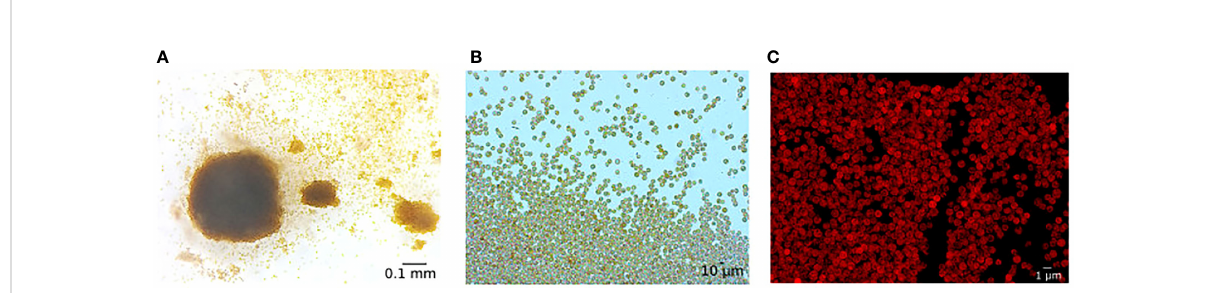
FIGURE 4 Fecal pellet of B.stephanieae containing intact, photosynthetically active dino fl agellates. Image taken (A) by Corinna Sickinger with a stereo microscope (SteREO Discovery.V8, Zeiss, Germany), 80× magni fi cation, (B) by Jenny Melo with a light microscope (Imager A2, Zeiss, Germany), 200×, and (C) with a fl uorescence microscope (BZ-X800E, Keyence, Japan), using the Texas Red Filter and a 400× magni fi